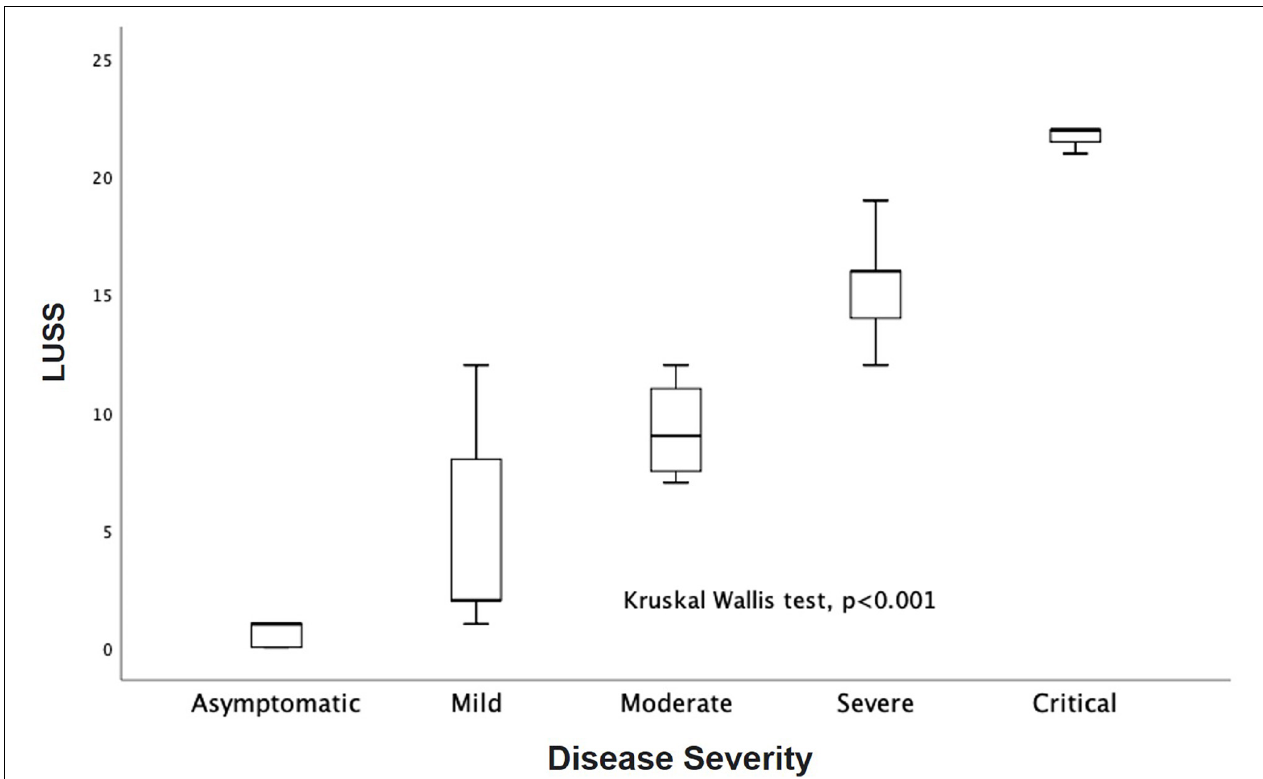
FIGURE 5 | LUSS median differences between disease severity (Kruskal–Wallis, p =